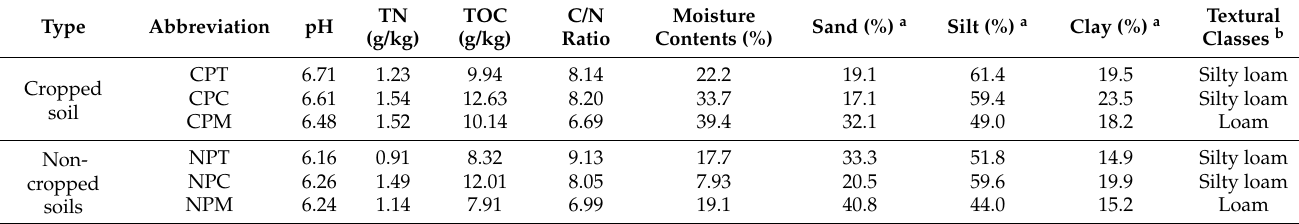
Table 1. Edaphic properties of the selected cropped and non-cropped soil samples (mean values).